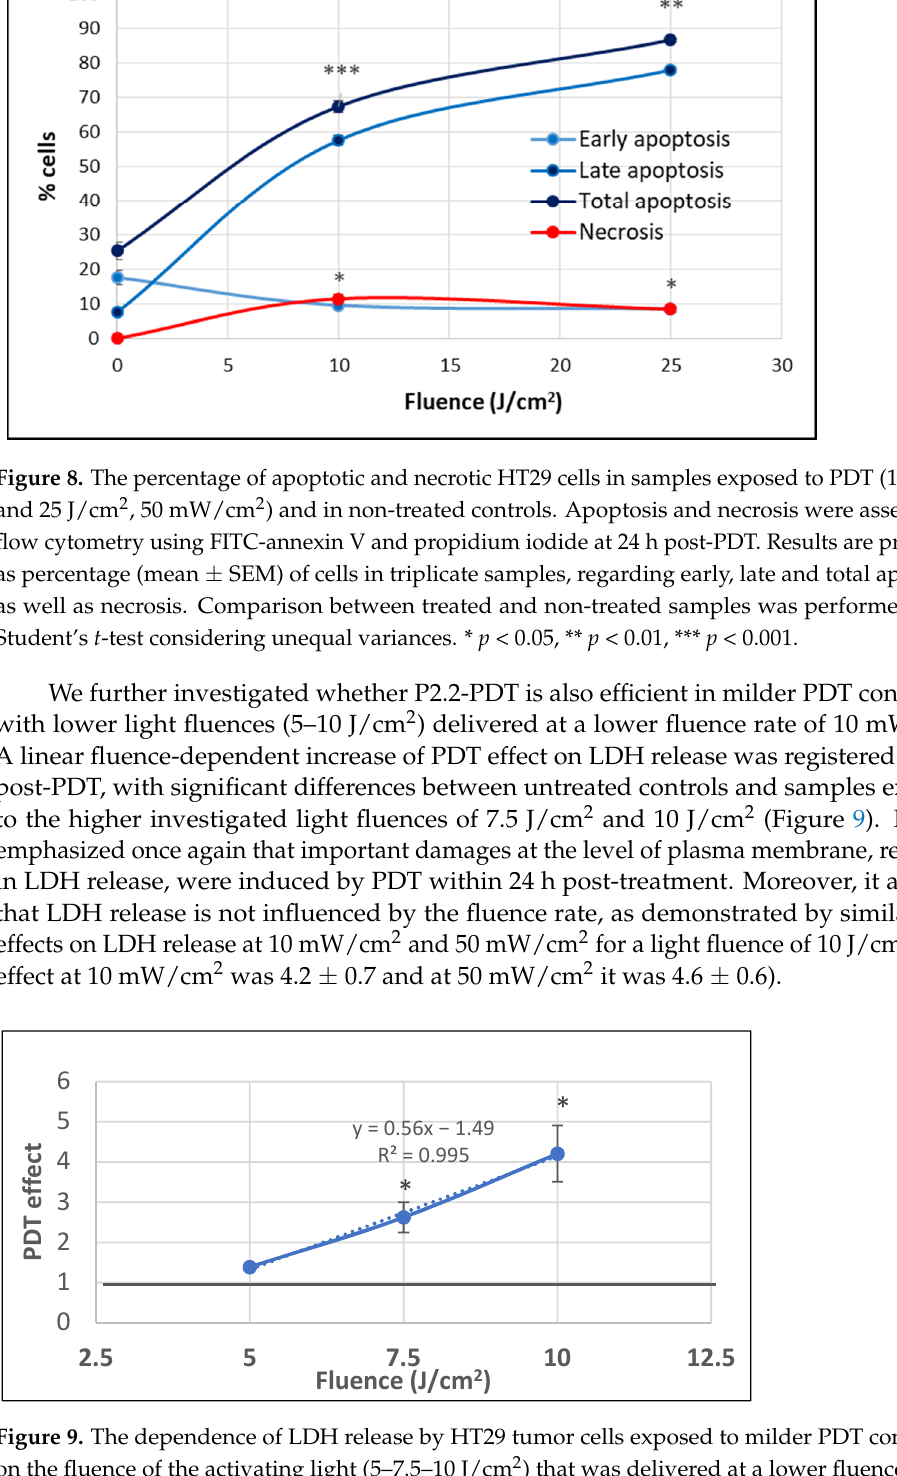
7 of 25 Comparison between samples was performed using Student’s t -test considering unequal variances: comparison between PDT regimens at a specific time-point: * p < 0.05, ** p < 0.01, *** p < 0.001; comparison between samples at 24 h and 72 h: # p < 0.05, ### p < 0.001. At 24 h post-PDT, when the percentage of metabolically active cells decreased drastically below 50% in a fluence-dependent manner (Figure 4), many cells were found